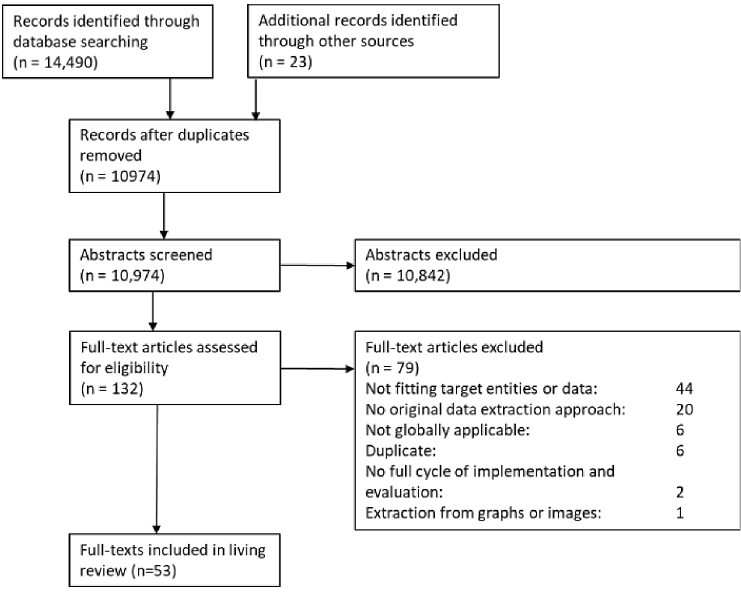
Figure 2. PRISMA flow